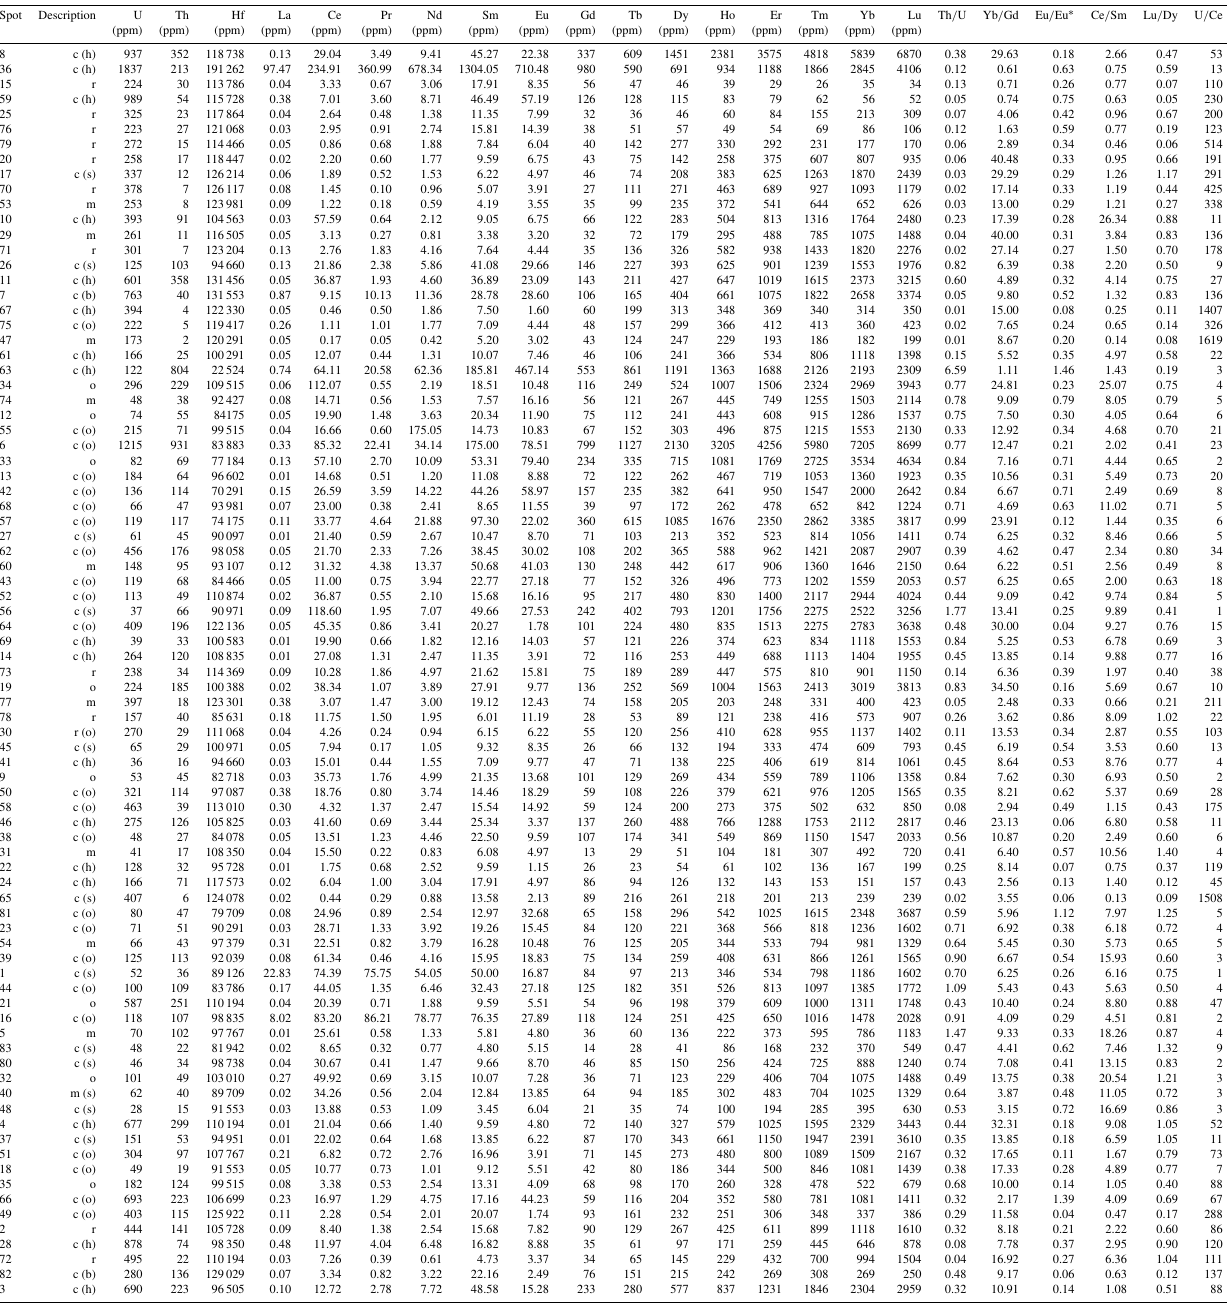
Table 4. REE zircon_McD_S sorted by